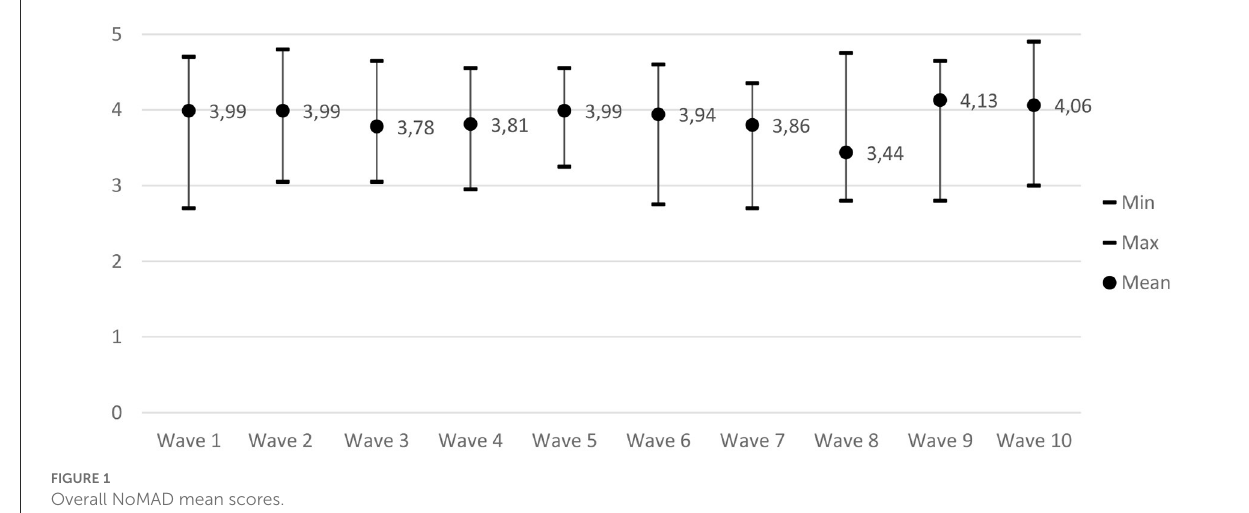
FIGURE1 Overall NoMAD mean